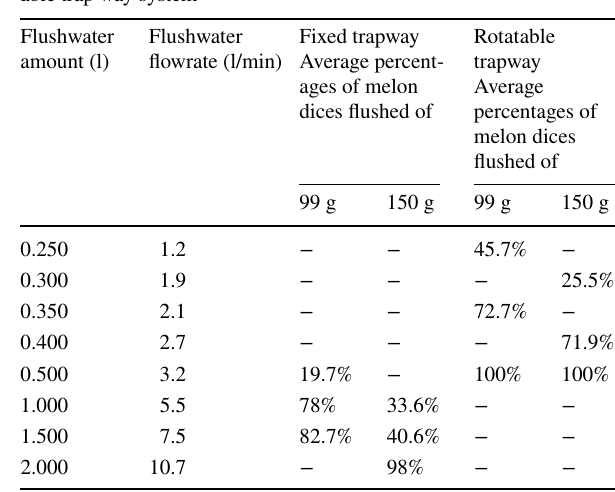
Table 2 Results obtained of experiments on the pedal